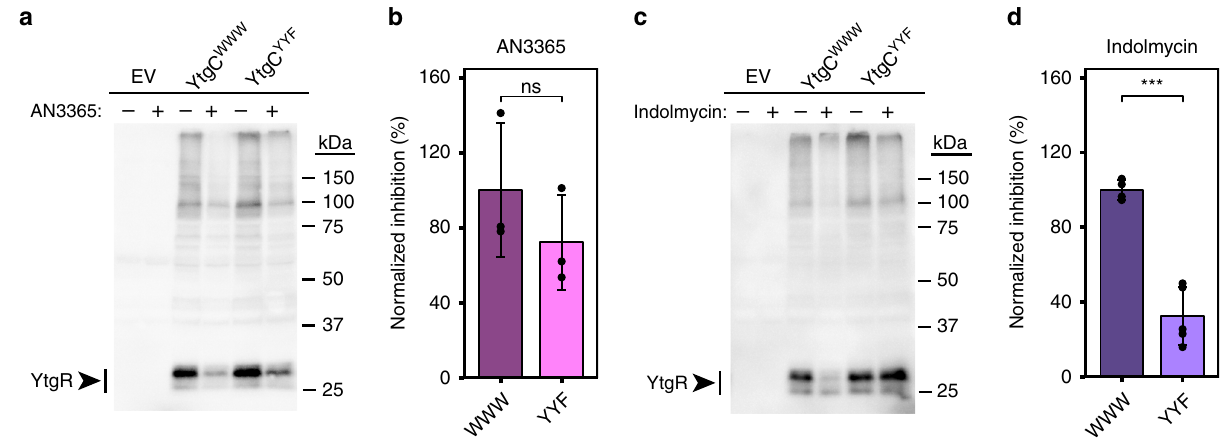
Fig. 3 Indolmycin inhibits YtgR expression in a WWW motif-dependent manner. a Immunoblot of pET151-YtgCR-3xFLAG (WWW or YYF) expression from BL21 (DE3) E. coli lysates in the presence or absence of 10 µ g/mL of the leucyl-tRNA synthetase inhibitor, AN3365. Experiments were performed in M9 minimal media supplemented with 0.2% D-glucose. YtgCR-3xFLAG was detected with a monoclonal FLAG antibody. Images are representative of at least three independent experiments. b Densitometric quanti fi cation of YtgR expression following AN3365 treatment relative to the mock treated control group and normalized to the mean of the WWW group. c Equivalent experiment to that described in a with the exception that cultures of transformed E. coli were treated with 1.0 µ g/mL of the tryptophanyl-tRNA synthetase inhibitor, indolmycin. d Equivalent quanti fi cation to that described in b for indolmycin-treated experiments. Data represent mean ± s.d. of at least three independent biological replicates. Statistical signi fi cance in all panels was determined by pairwise two-sided unpaired Welch ’ s t -test for unequal variance. * p < 0.05, ** p < 0.01, *** p < 0.001. Source data for this fi gure are provided in Source